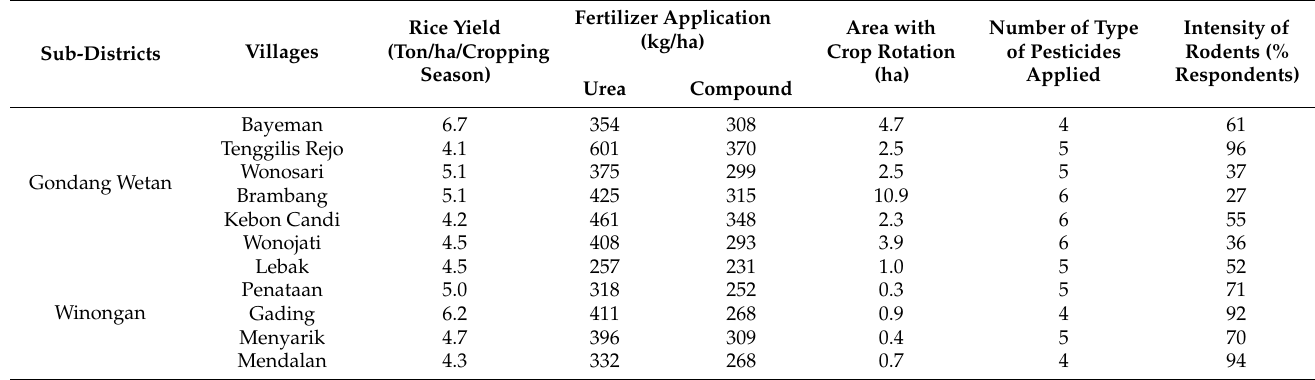
Table 5. Distribution of rice yield (ton/ha), fertiliser application (kg/ha), number of type of pesticides applied, water sources (% respondent), and intensity of rodents (% respondent) in each village in two sub-districts.